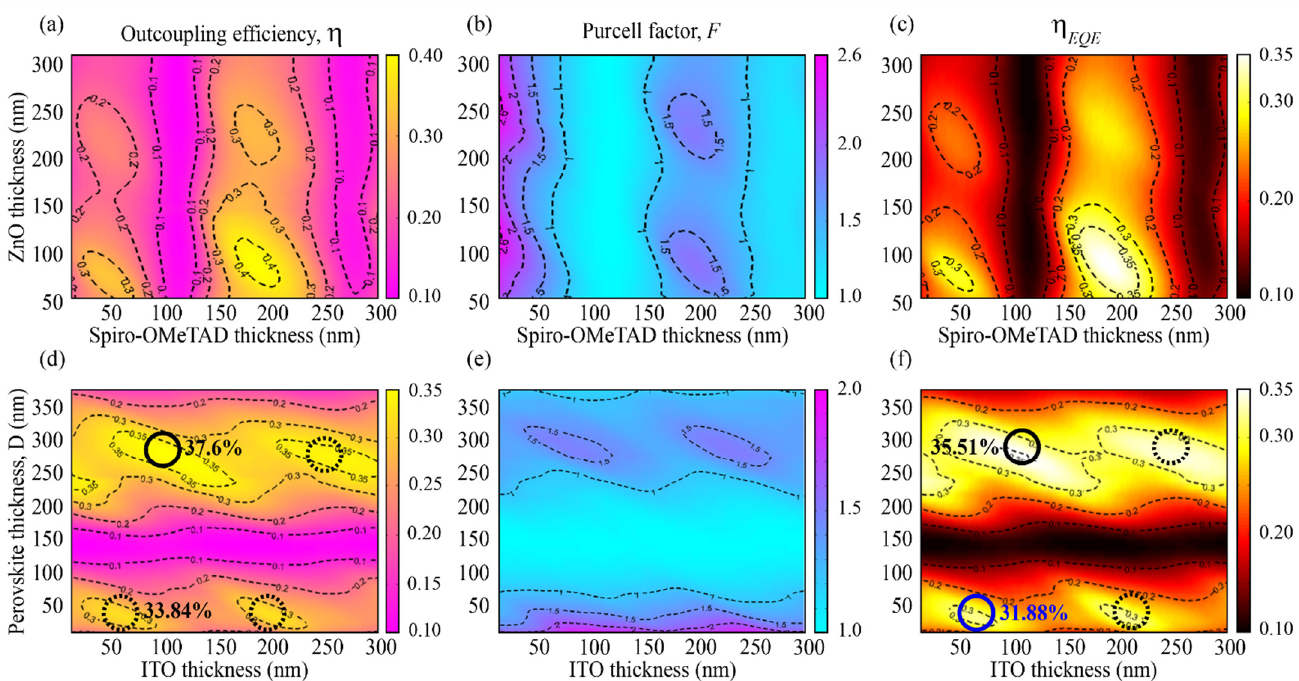
Figure 4. ( a ) Outcoupling efficiency η , ( b ) Purcell factor F , ( c ) η EQE of PeLED as functions of ZnO and Spiro-OMeTAD thicknesses at emission wavelength 540 nm (Ag = 100 nm, ITO = 200 nm, CsPbBr3 = 40 nm). ( d ) Outcoupling efficiency η , ( e ) Purcell factor F , ( f ) η EQE of PeLED as functions of ITO and perovskite thicknesses at emission wavelength 540 nm (Ag = 100 nm, Spiro-OMeTAD = 50 nm, ZnO = 40 nm). The circles represent local maxima. Isotropic dipoles distribution is assumed for all figures.